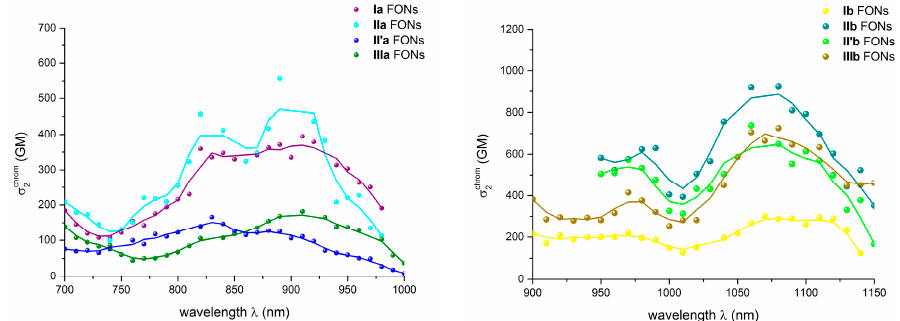
Figure 6. Comparison of the 2PA spectra of dyes for FONs of series I – IIIa ( left ) and I – IIIb ( right ).